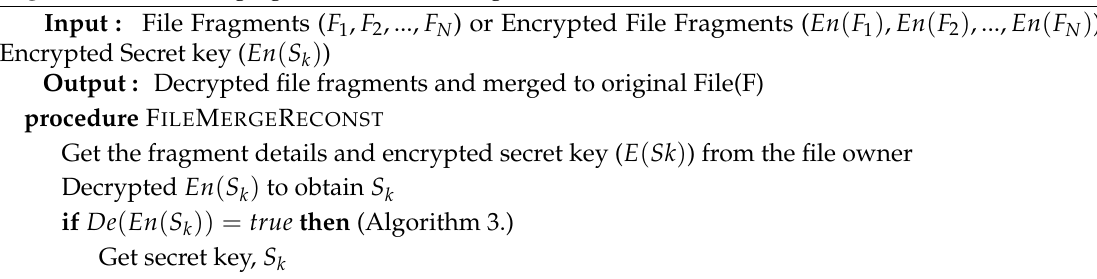
Algorithm 2 File Merging and